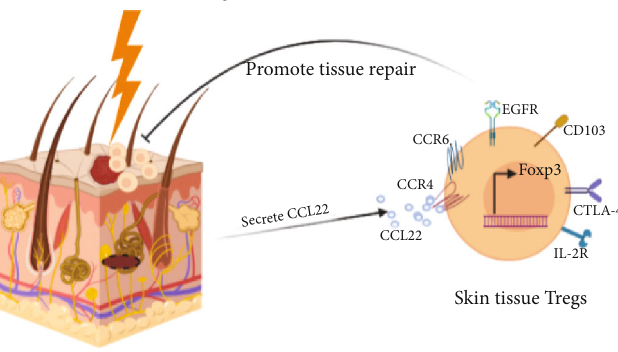
Figure 4: Skin Treg phenotype and function. Skin tissue Tregs are characterized with expression of phenotypic markers, CTLA-4, IL-2R, Foxp3, and CD103, and chemokine receptors, CCR4 and CCR6. These Tregs will be recruited to the damaged tissue with expression of homing molecules such as CD103 and CCR4 after UVB exposure. CCL22 derived from the damaged tissue, a chemokine binding to CCR4, will recruit these Tregs, which fi nally promote the tissue repair. In addition, EGFR expression on these cells can promote skin Treg activation and enhance skin Treg